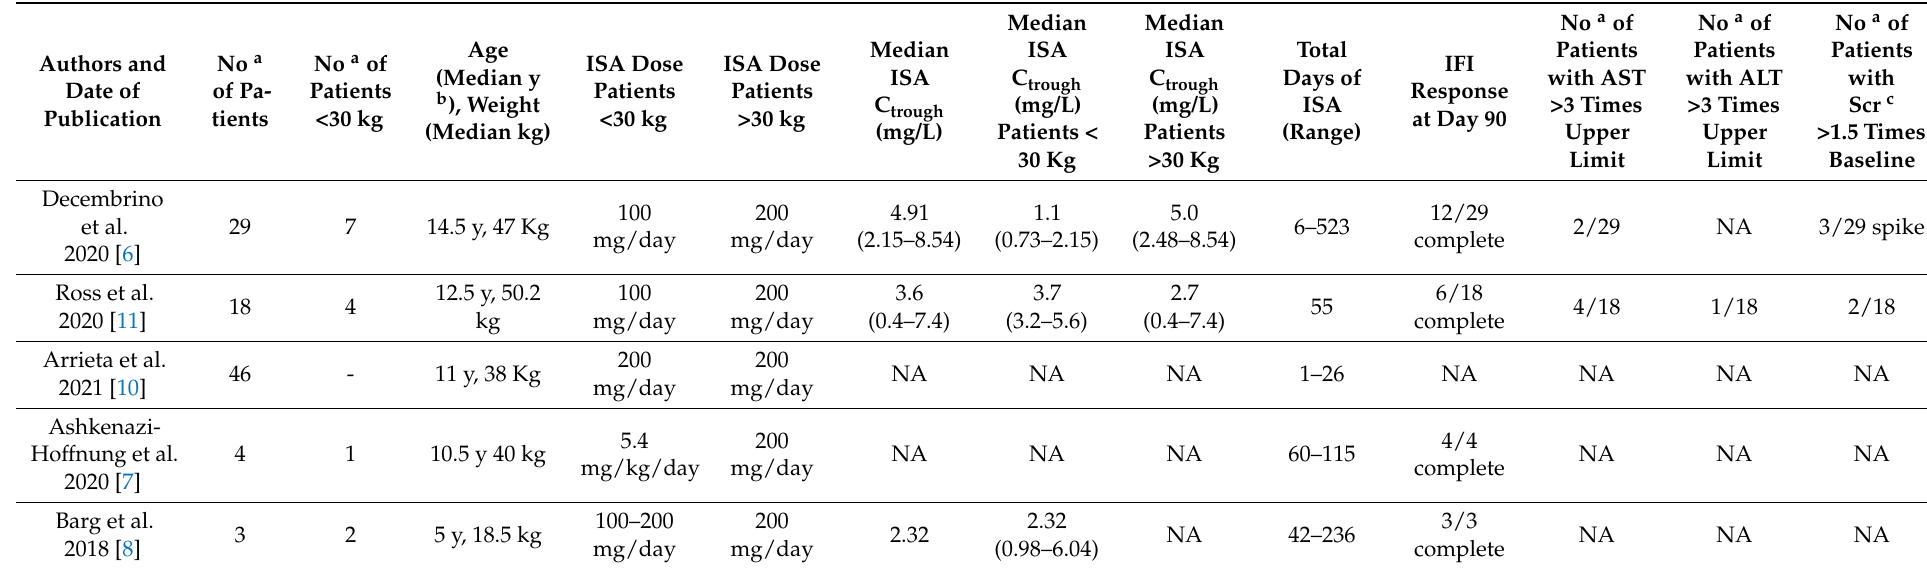
Table 2. Review of literature